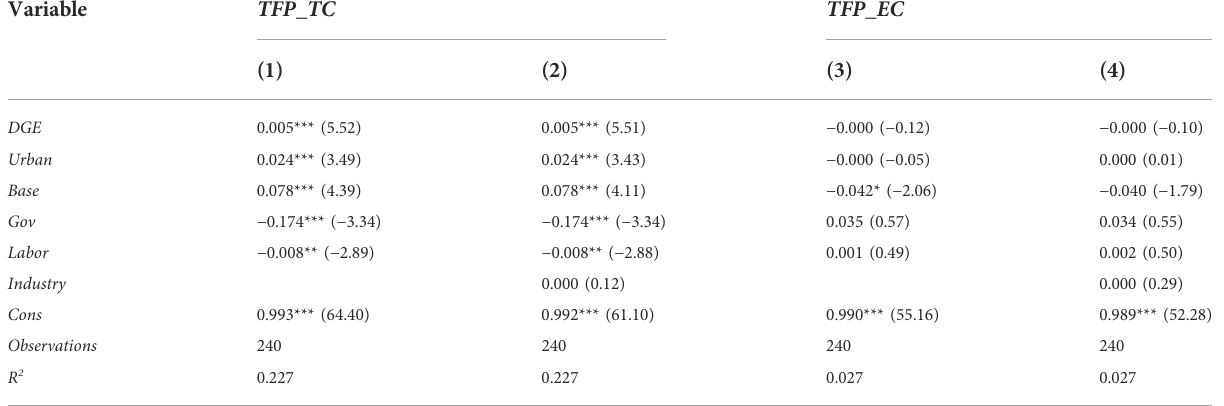
TABLE 10 Robustness test for replacing core explanatory